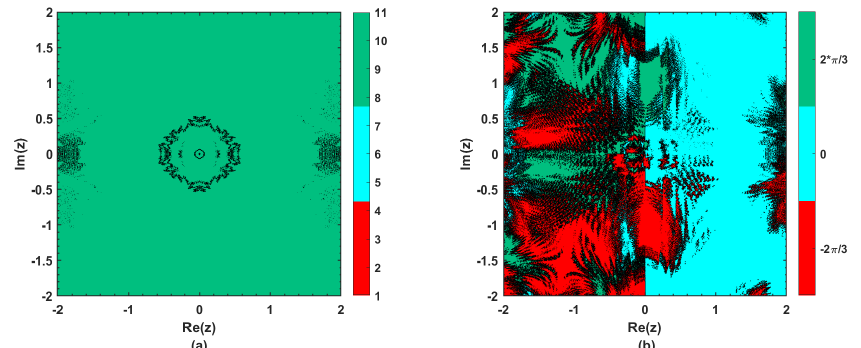
Figure 6. The polynomiographs obtained by the proposed method PS9 for P 6 ( z )